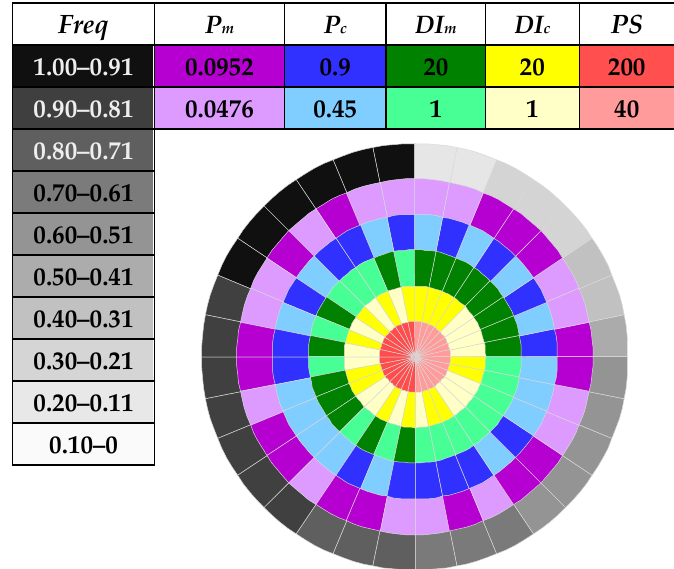
Figure 3. Parameterization of NSGA-II applied to the New York Tunnel Network (NYT) design